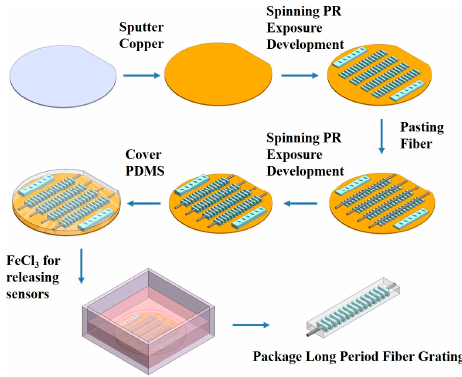
Figure 1. The production process of the packaged long-period fiber gratings (PLPFG) strain sensor.